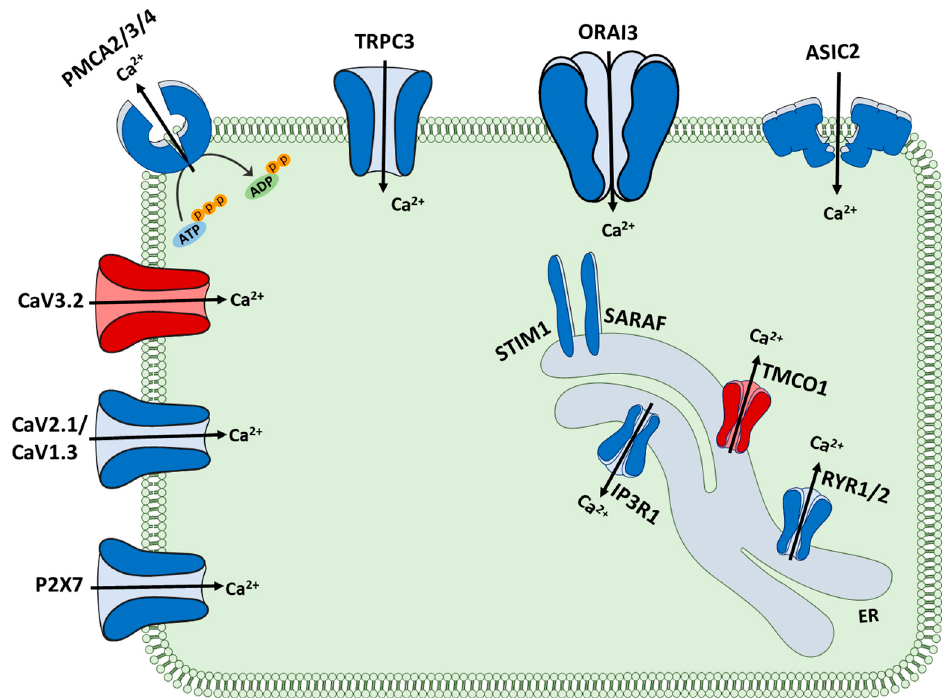
Figure 8. Schematic representation of the 16 Ca 2+ regulators with altered expression in MB compared to normal brain. The 2 regulators with upregulated expression are shown in red, while the 14 regulators with downregulated expression are shown in blue.